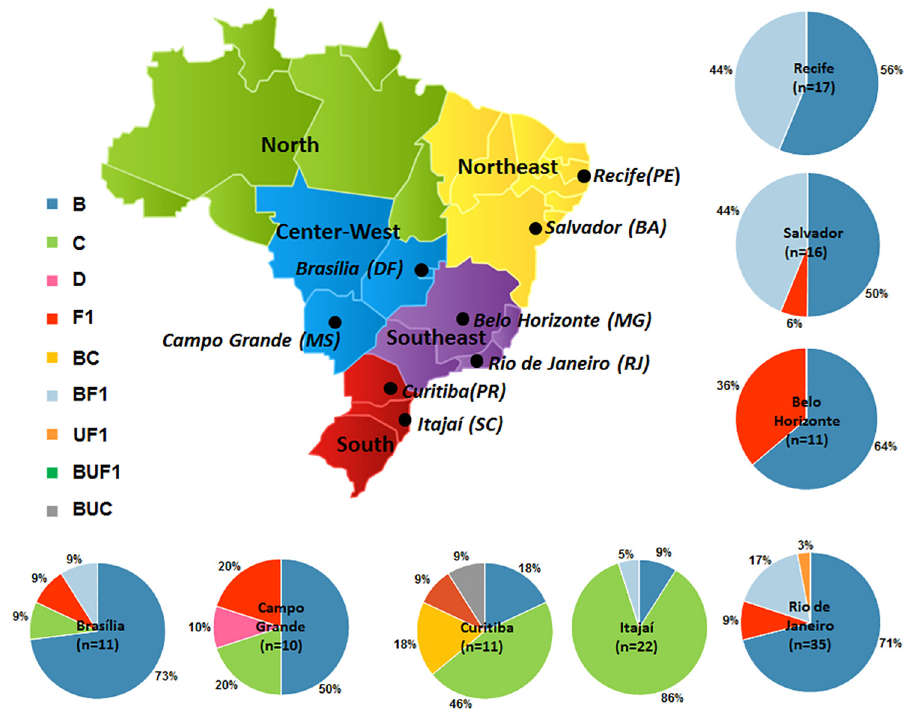
Fig 1. Map of Brazil showing the frequency of HIV-1 genetic variants across the nine studied cities/ State [Recife (PE), Salvador (BA) — Northeast region], [Rio de Janeiro (RJ), Belo Horizonte (MG) — Southeast region], [Itajaí (SC), Curitiba (PR) — South Region], [Campo Grande (MS), Brasilia (DF) — Center West region]. The number of env and pol analyzed samples was depicted in each graphic.